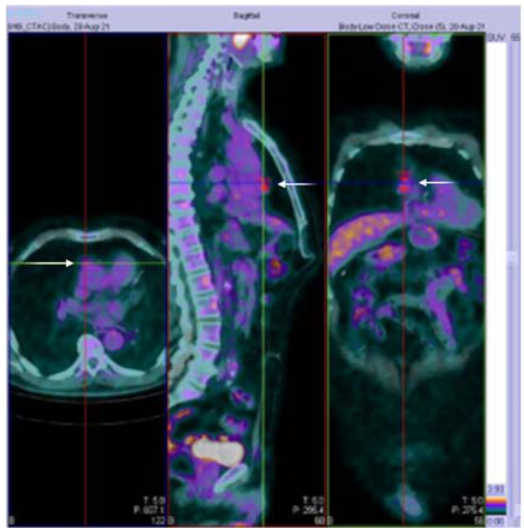
Figure 2. Positron emission tomography (PET) ‐ CT of our patient. Fused 18fluorodeoxyglucose [18F]FDG ‐ PET and CT transverse, sagittal, and frontal images confirming a moderate [18F]FDG uptake in the anterior mediastinum (white arrows) with a maximum standardized uptake value (SUV) of 3.16, consistent with the suspicion of ectopic mass (most probably thymoma). The SUV is the ratio of the image ‐ derived radioactivity concentration and the whole ‐ body concentration of the injected radioactivity, and some authors have suggested that SUV is increasingly higher in thymic mass according to the WHO classification [19]. The histologic analysis confirmed the thymoma diagnosis.